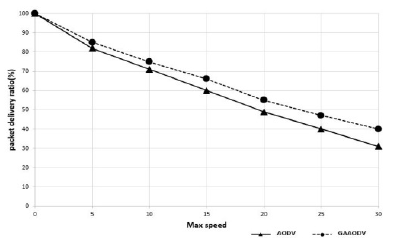
Fig. 3. Comparison of packet delivery Fig. 4 . Fig. 5 . Comparison of average end